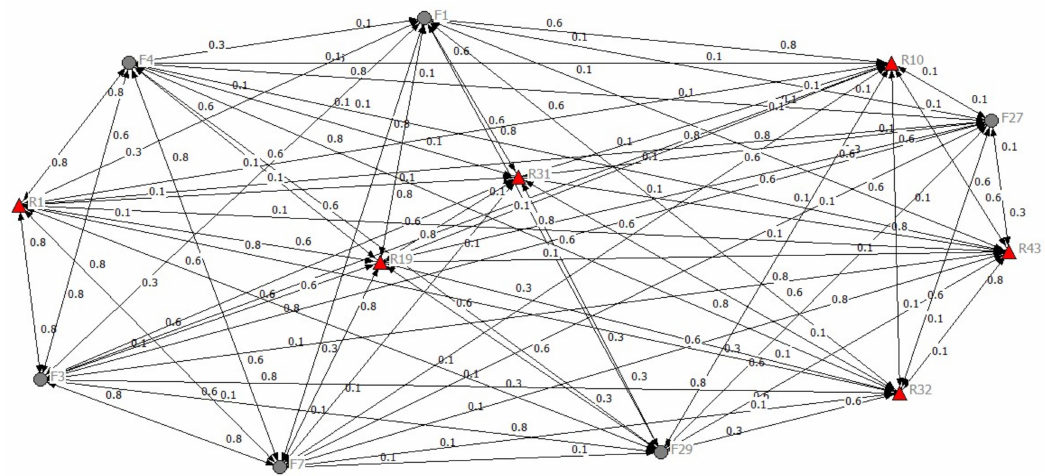
Figure 2. Causal-relationship network from the